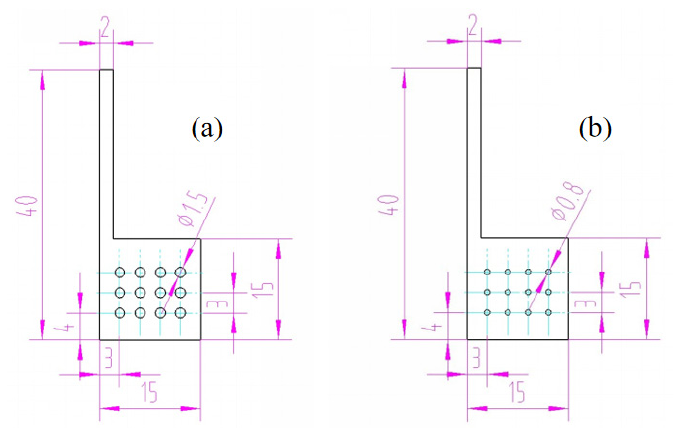
Figure 3. Drawing of holes on the photoanode. ( a ) holes in φ 1.5 mm; ( b ) holes in φ 0.8 mm. The units of the figures are in millimeters.